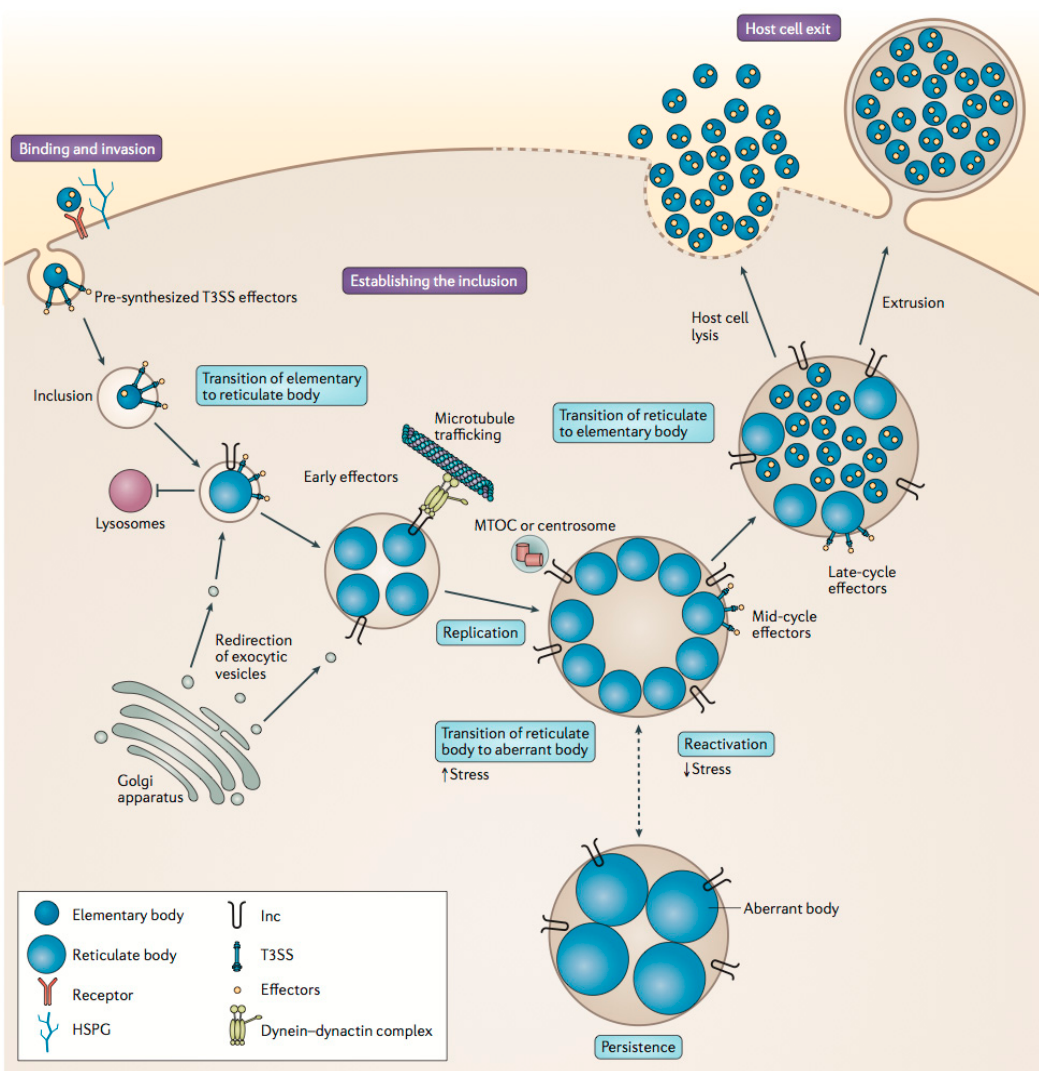
Figure 2. The life cycle of Chlamydia trachomatis . The elementary body (EB) binds to the host cell. Compounds are injected into the host cell to initiate internalization and establish an antiapoptotic state. The EB is incorporated into an endosomal membrane to form an inclusion, which is freed from the cell wall and passes into the host cell cytoplasm. Through bacterial protein synthesis the EB converts to reticulate bodies (RBs), which redirect host cell nutrients and divide by binary fission. The RBs direct host cell function and continue to replicate exponentially. If the RBs are excessively stressed they enter a dormant persistent state to promote survival, and reactivate upon removal of stress. Within 30–48 h the RBs differentiate back to EBs, which then exit the host cell through lysis or extrusion. Adapted with permission from [28]. Copyright 2016 Nature Publishing Group.